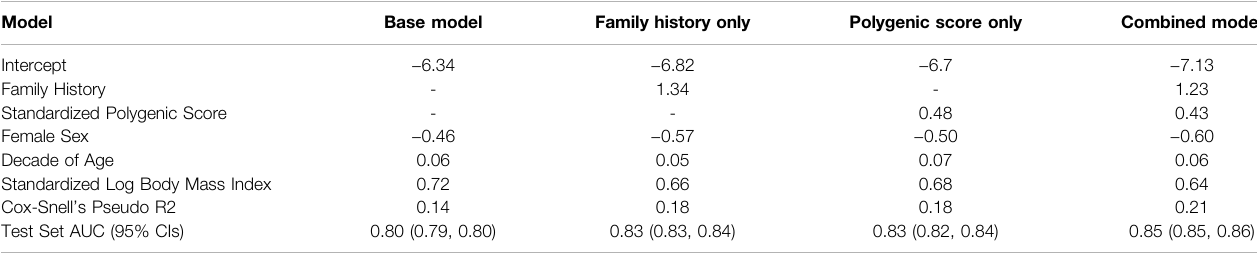
TABLE 2 | Logistic regression between prevalent T2D, family history, and the PGS among those of European